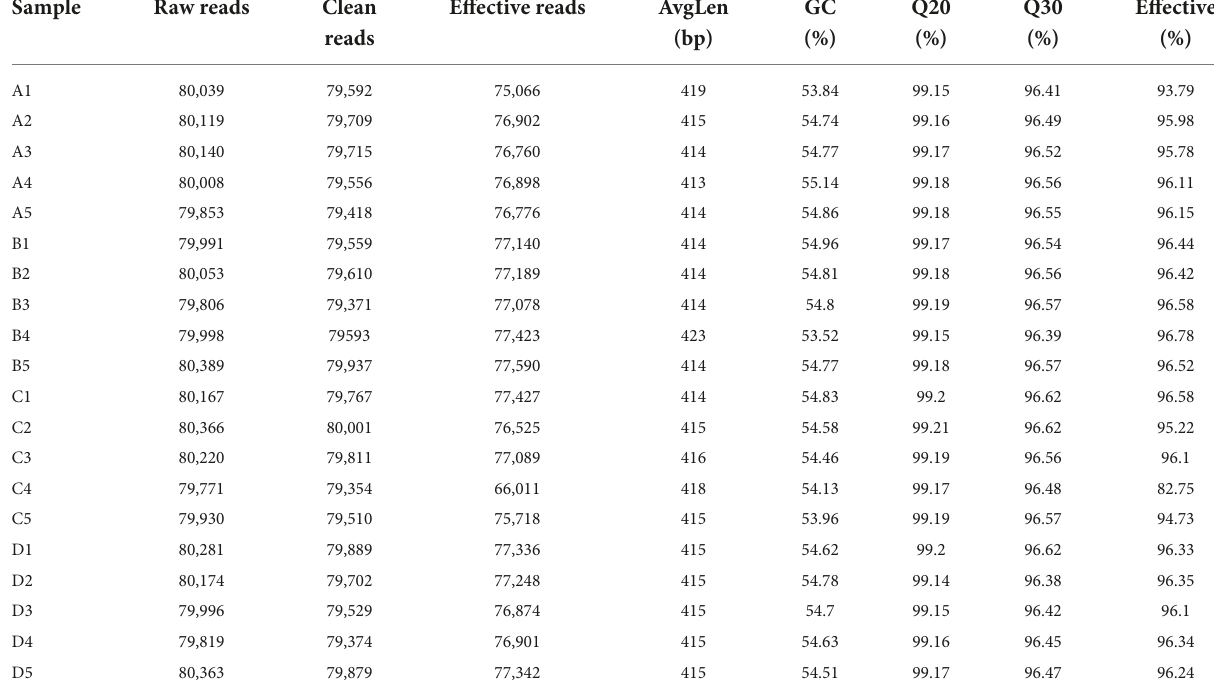
TABLE 1 The sequence information of each